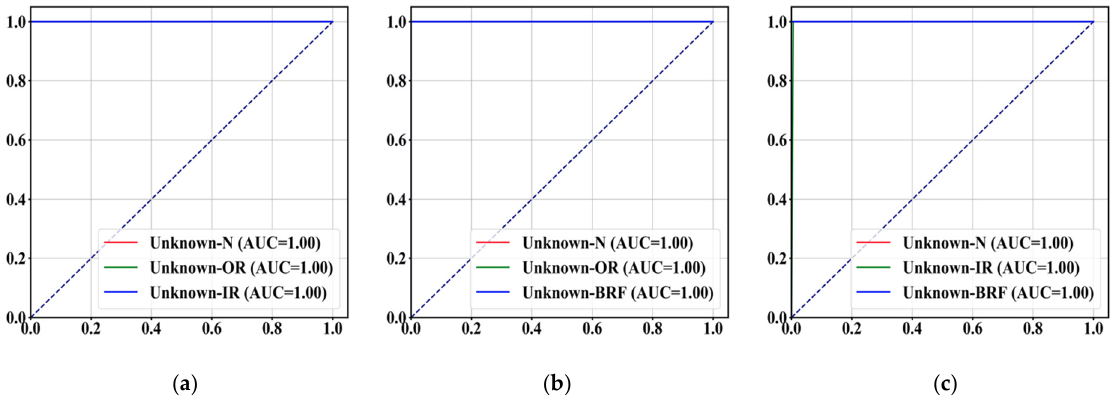
Figure 6. ROC/AUC of feature transferring from Ottawa to CWRU. ( a ) Hidden the labels of BRF faults. ( b ) Hidden the labels of IR faults. ( c ) Hidden the labels of OR faults.